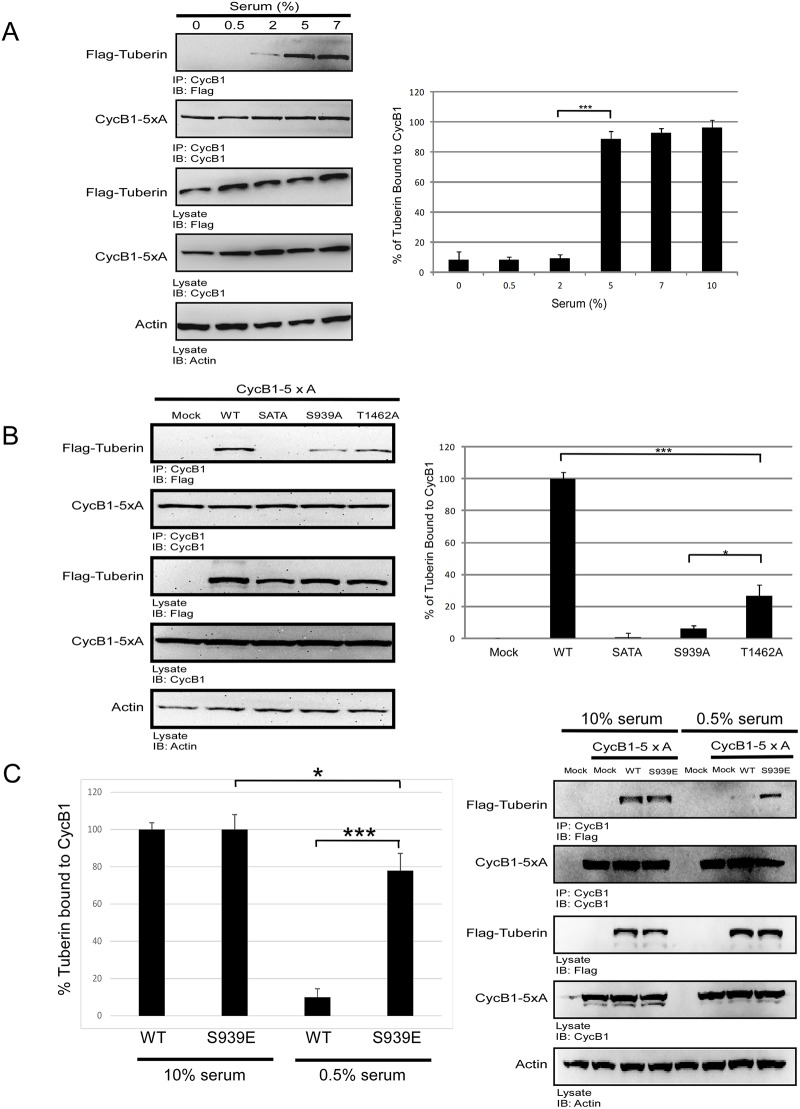
TSC2-CycB1 interaction is serum and Akt phosphorylation dependent.(A) HEK293 cells were transfected with Flag-TSC2 and CycB1-5xA. 18 hrs post-transfection, cells were washed with PBS and incubated for 2 hrs with different concentrations of serum (indicated as % serum). Cell lysates were subjected to IP using CycB1 antibody Representative blots; left panel. Densitometry analysis was conducted measuring the % of Tuberin bound to CycB1 (CycB1*100/Tuberin densitometry values; Y-axis) (right panel). Errors represent SD over 3 separate transfections. Unpaired t-test, *** p< 0.001. (B) HEK293 cells were transfected with CycB1-5xA and either pCMV-Mock control, Flag-WT-TSC2, Flag-TSC2-SATA, Flag-TSC2 S939A or Flag-TSC2 T1462. 18 hrs post-transfection cells were lysed and subjected to IP using CycB1 antibody. Representative immunoblots are shown (left panel). Densitometry analysis was conducted measuring the % of Tuberin bound to CycB1 (CycB1*100/Tuberin densitometry values; Y-axis) (right panel). Errors represent SD over 3 separate transfections. Unpaired t-test, * p< 0.05 and *** p < 0.001. (C) HEK293 cells were transfected with CycB1-5xA and either pCMV-Mock control, Flag-WT-TSC2 or Flag-TSC2-S939E. 18 hrs post-transfection cells the cells were incubated with 10% or 0.5% serum, 2 hrs after the cells were lysed and subjected to IP using CycB1 antibody. Representative immunoblots are shown (left panel). Densitometry analysis was conducted measuring the % of Tuberin bound to CycB1 (CycB1*100/Tuberin densitometry values; Y-axis) (right panel). Errors represent SD over 3 separate transfections. Unpaired t-test, * p< 0.05 and *** p< 0.001.